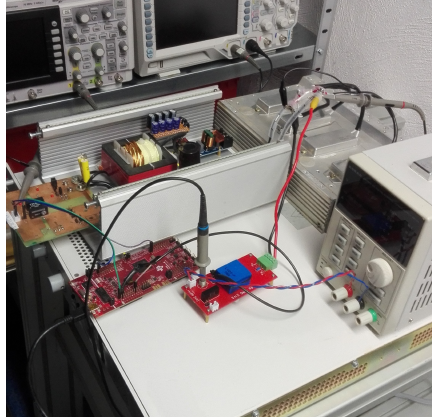
Figure 2. Experimental setup of a boost converter used for analysis conducted in this article. The cir- cuit corresponds to a circuit diagram shown in Figure 3 with parameters as per Table